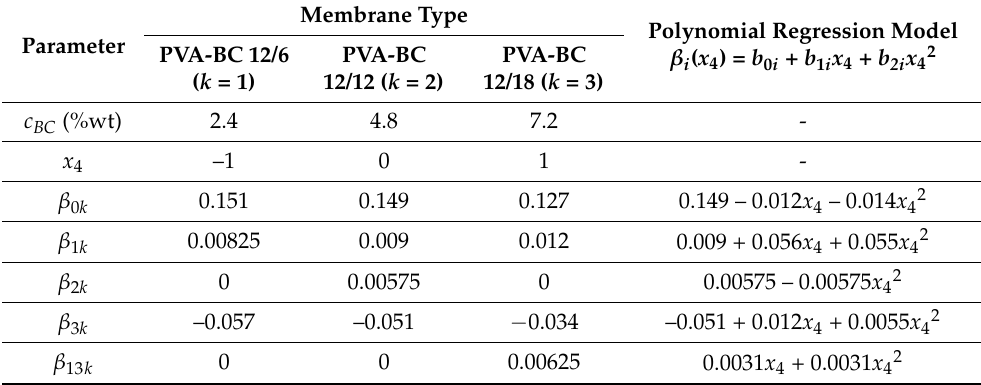
Table 3. Regression coefficients β ik ( i = 0, 1, 2, 3, 13, k = 1..3) depending on BC content in the